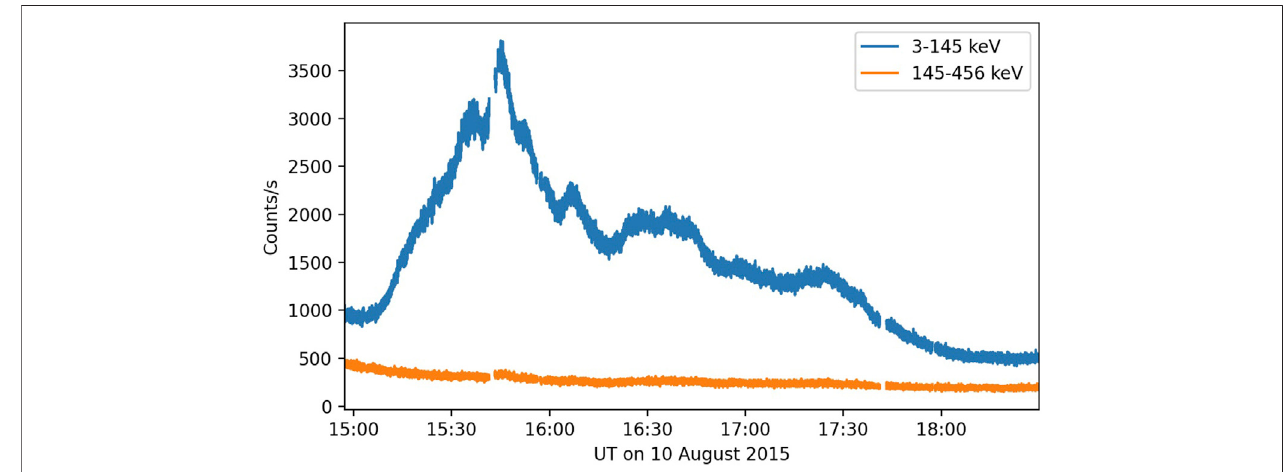
FIGURE 1 | BARREL Payload 3 A x-ray count rate versus time in two energy ranges: 3 – 145 keV (blue) and 145 – 456 keV (orange), observed on August 10, 2015. The 50 ms FSPC data have been summed to a 1 s